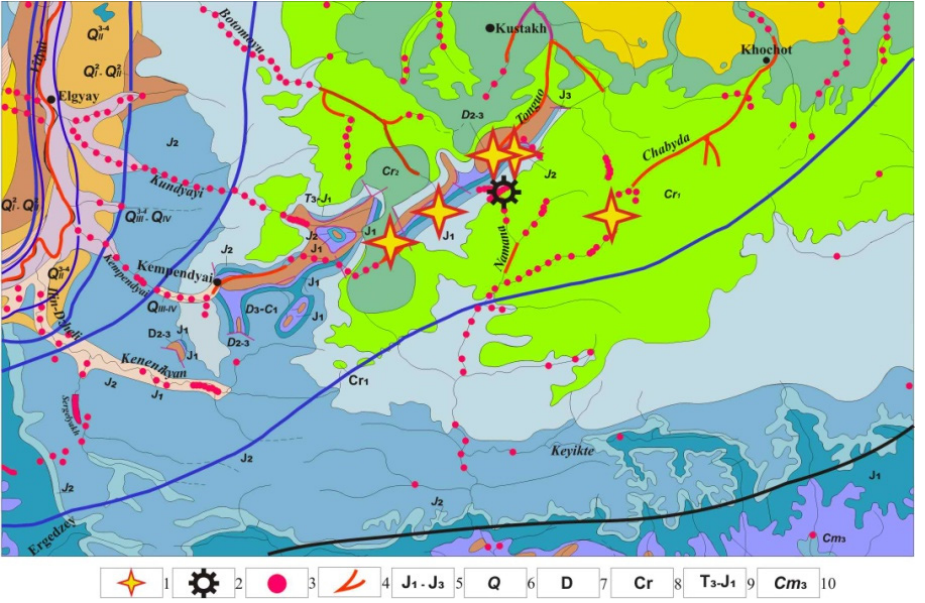
Figure 3. The location of placers in the area of the Kempendyai dislocations, whose sources were hydrothermal metasomatic formations (sideritized siltstones, argillizated rocks, quartz-carbonate veins). Conventional symbols: 1—ore occurrences; 2—volcanic pipe; 3—stream sediment samples, containing gold; 4—explored placers. Deposits: 5—Quaternary; 6—Cretaceous; 7—Jurassic; 8—Triassic; 9—Devonian; 10—Cambrian. The scheme is based on the map of the gold content of Western Yakutia, 2001, scale 1: 1,500,000.